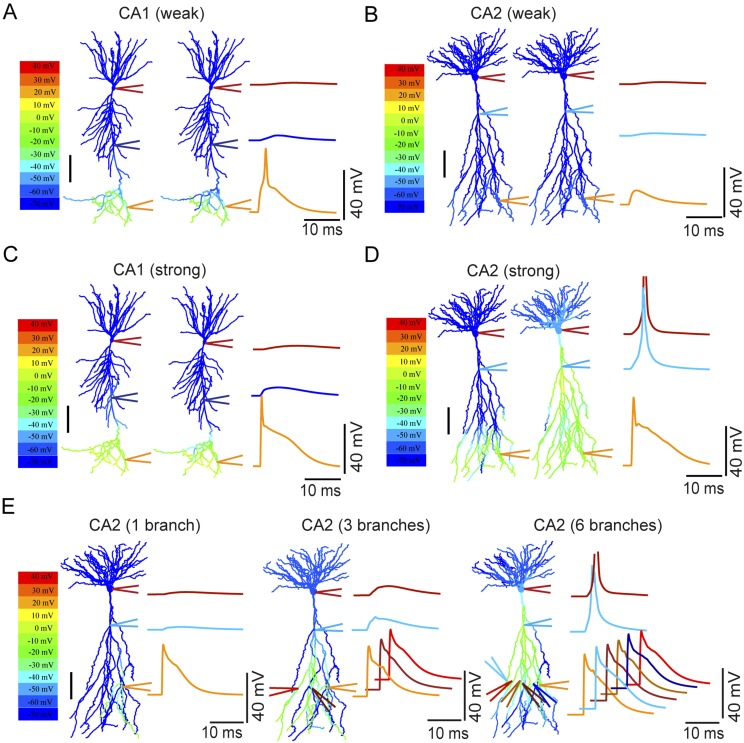
Modeling the differential coupling of dendritic Na+ spikes to AP output in CA1 vs CA2 dendrites.(A, B) Weak PP stimulation (∼75 synapses) triggered local spikes at distal apical dendrites in CA1 (A), but not in CA2 (B), PNs. In both models, dendritic spikes failed to propagate to the soma. (C) Strong PP stimulation (∼1000 synapses) triggered local Na+ spikes in the apical tuft of the CA1 PN that failed to propagate to the soma. (D) Strong PP stimulation (∼1000 synapses) triggered local Na+ spikes in the apical tuft of CA2 PN that propagated effectively to the soma and triggered an AP. Note the presence of a prominent dendritic Na+ spike at the CA2 PN primary apical dendrite branch point. APs are truncated. Color maps in (A–D) represent voltage snapshots. Left: snapshot taken at the time of peak voltage response in distal dendrites of CA1 and CA2 PNs. Right: snapshot taken at the time of peak voltage response at main apical dendritic trunk for CA1 PN or primary dendritic branch point for CA2 PN. Scale: 100 µm. Traces show voltage response at indicated positions. (E) Increasing numbers of secondary or tertiary CA2 apical branches (∼300 μm from the soma) were activated by ∼150 synapses per branch to trigger dendritic spikes. Offset traces at bottom show voltage responses in individual branches. Simultaneous activation of six out of twelve branches triggered a spike at the soma. Note a prominent dendritic Na+ spike at the branch point of primary apical dendrite of the CA2 PN. Color maps represent snapshots captured at time point of peak voltage observed at the main branch point of CA2 apical dendrites. Scale: 100 µm.